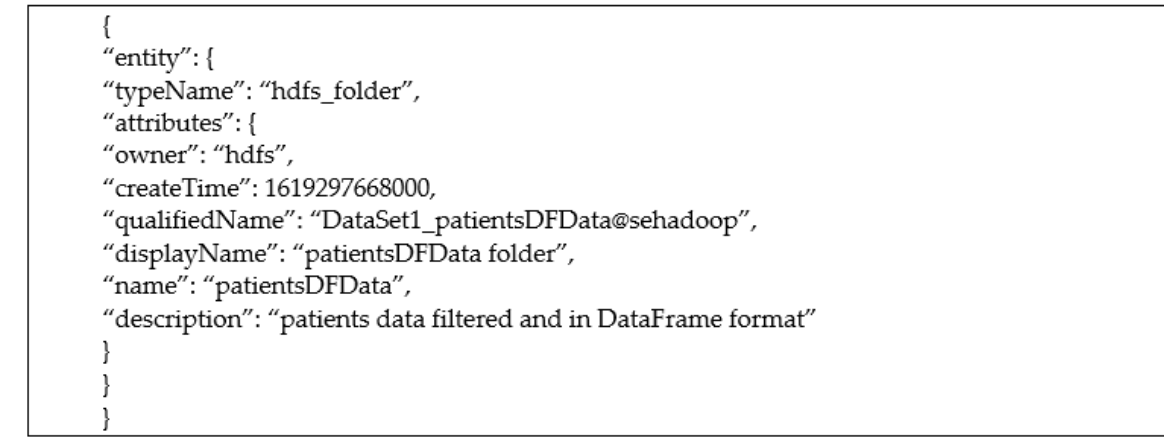
Figure 8. Example Atlas entity for HDFS folders with attributes.